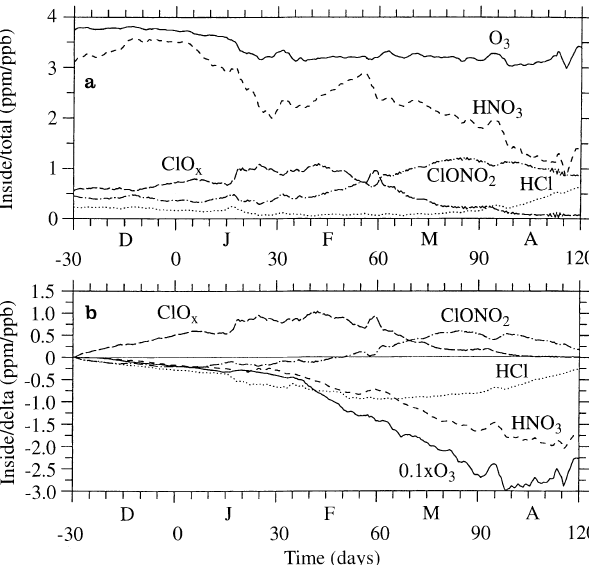
Fig. 6 a Temporal development of the mean mixing ratios of various trace gases at 50 hPa during a northern-hemisphere model winter inside the polar vortex (experiment CNTL); b influence of heteroge- neous reactions on PSCs inside the polar vortex (di(cid:128)erences of experiments ) (CNTL-HOM)). The units are ppbv, except for O ppmv in a and 0.1 ppmv